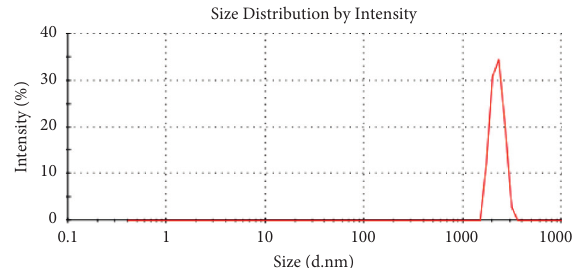
Figure 11: Particle size distribution graph of CP.